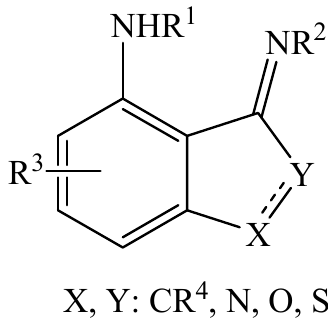
Figure 8. Suggested indene-like skeletons that may be suitable for molecular technology applications.